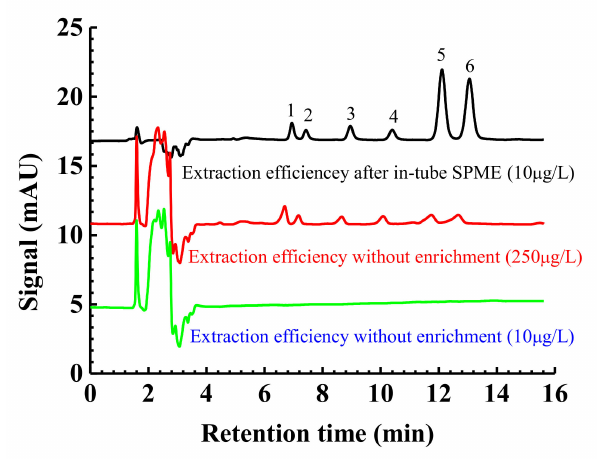
Figure 8. Comparative HPLC chromatograms before and after enrichment using the superhydrophilic wire or in-tube SPME. Peak order and other experimental conditions are the same as Figure 6.